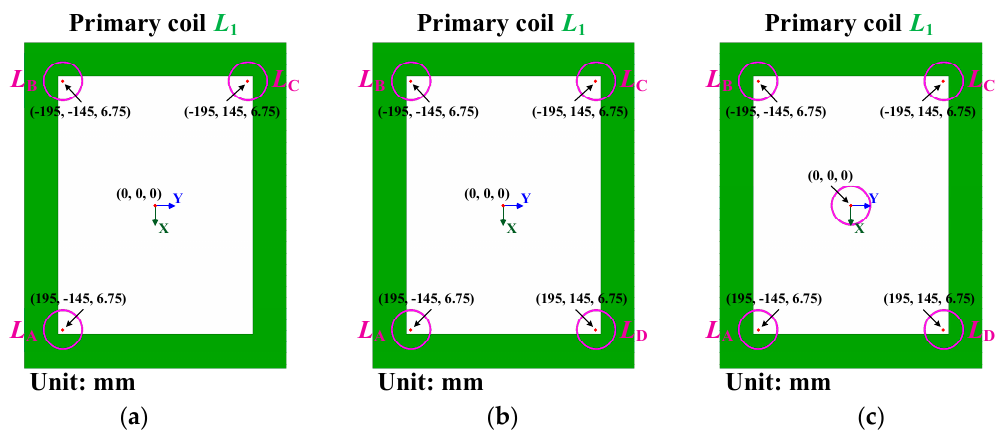
Figure 8. Placement with different coil number: ( a ) three signal coils; ( b ) four signal coils; ( c ) five signal coils.